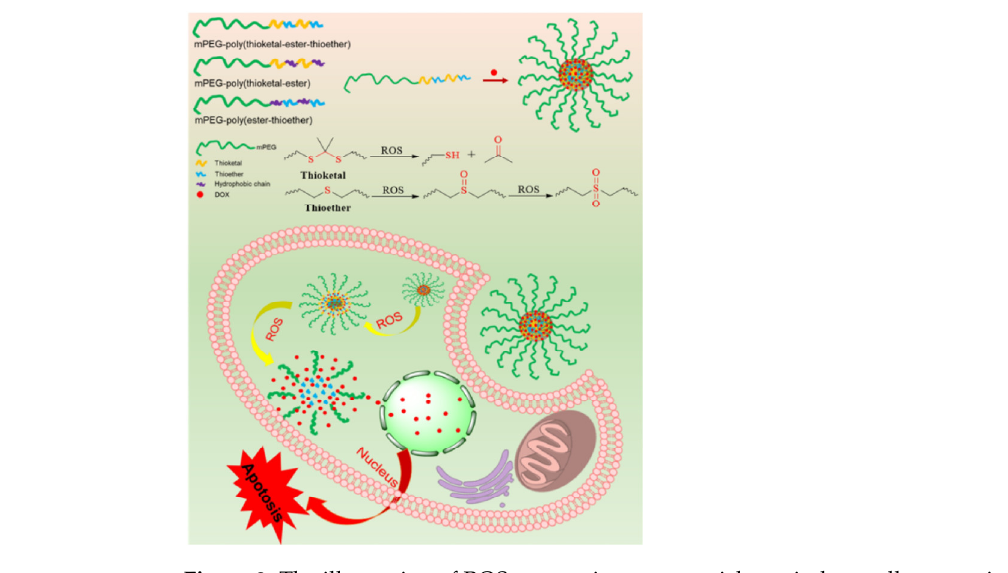
Figure 3. The illustration of ROS-responsive nanoparticles to induce cell apoptosis. Reprinted with permission from ref. [117]. Copyright © 2019 Elsevier B.V.